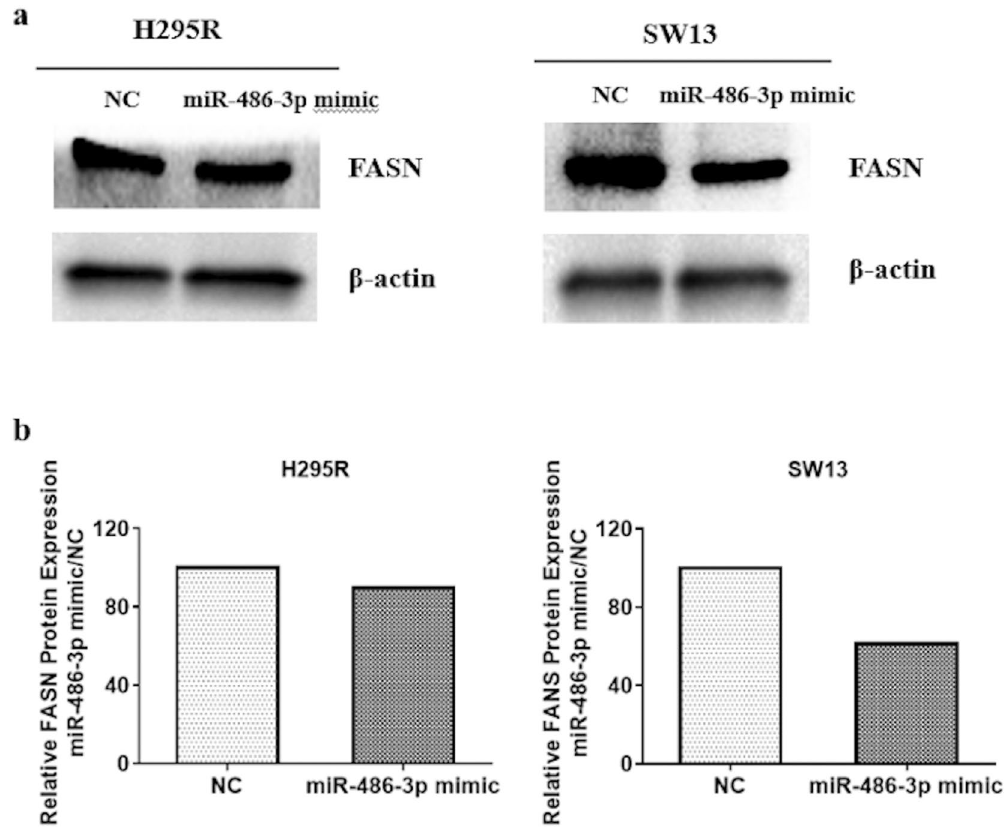
Figure 7. Protein assessments. ( a ) Western blot showing expression of FASN in H295R and SW13 cells transfected with miR-486-3p mimic compared to scrambled miRNA mimic (NC). ( b ) Graphical presentation of western blots analyses using β-actin for normalization. The experiments were performed three times. Full- length blots are presented in Supplementary Fig. 1.